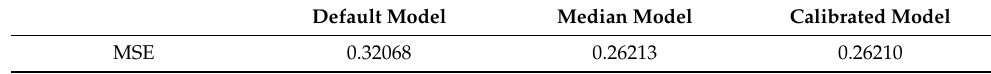
Figure 5. The posterior distributions of the reduced parameters of the 3-PG model developed in the present work. Table 6. Prediction error of the three candidate parametrization datasets for